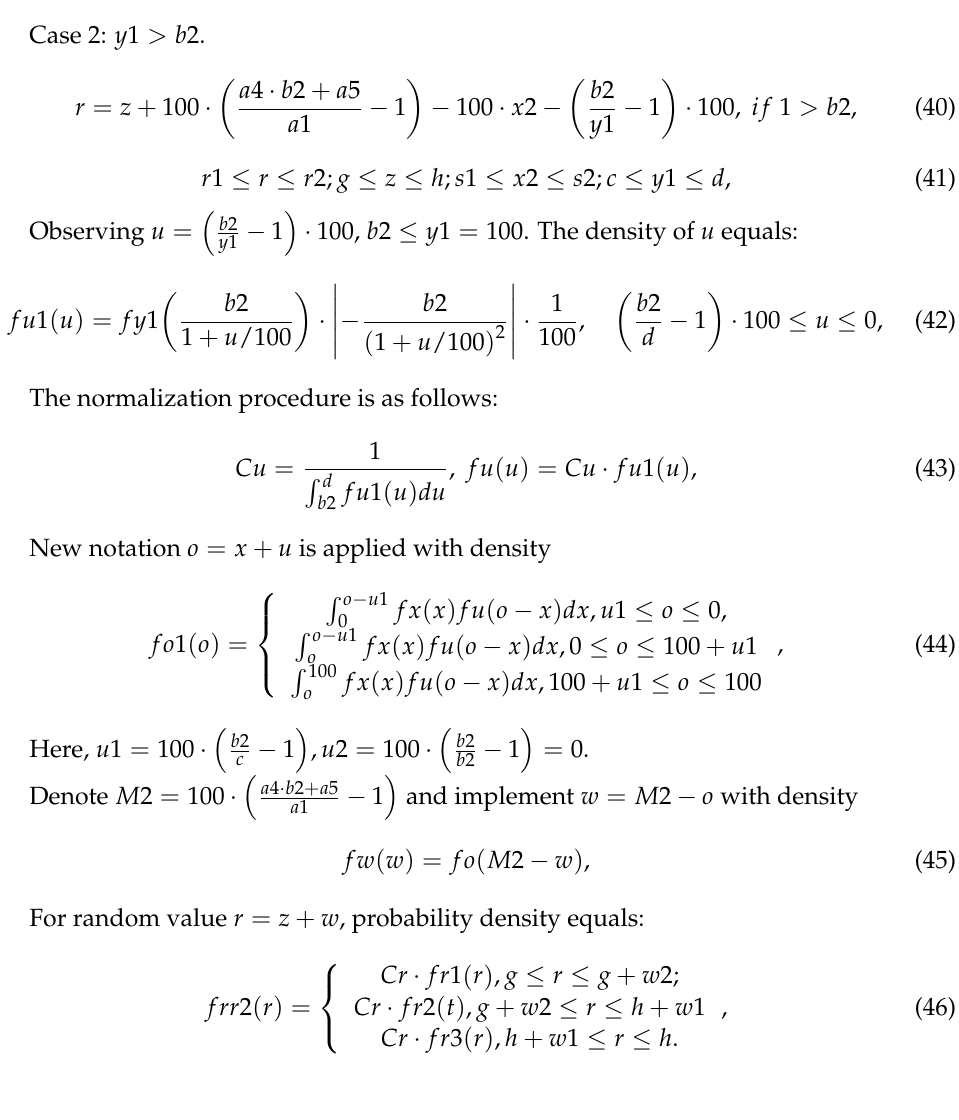
Figure 7. The labor satisfaction (Sat4) probability density ( 𝑦1 ≤ 𝑏2) .